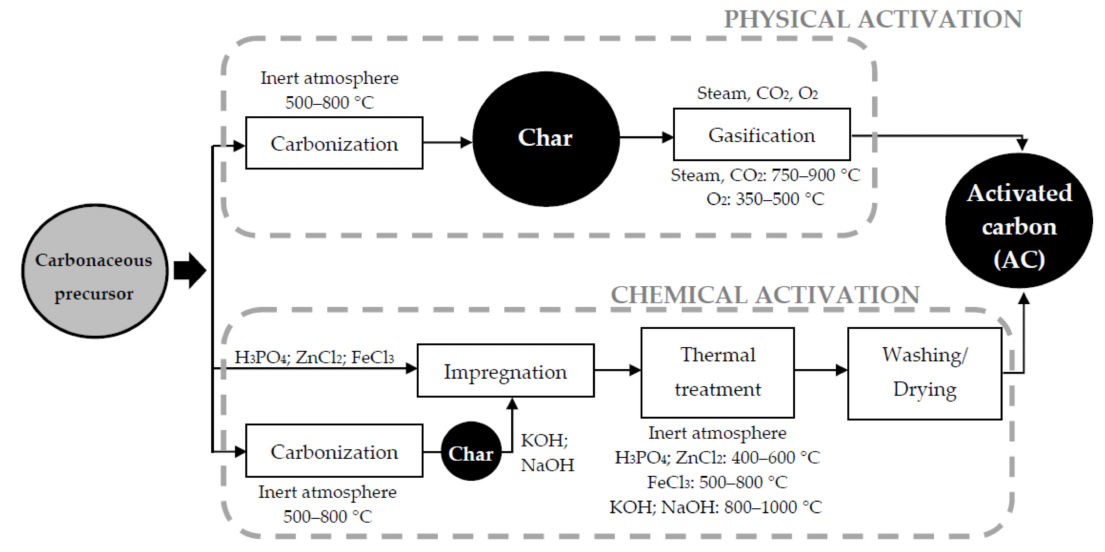
Figure 1. Synthesis of activated carbons (adapted from